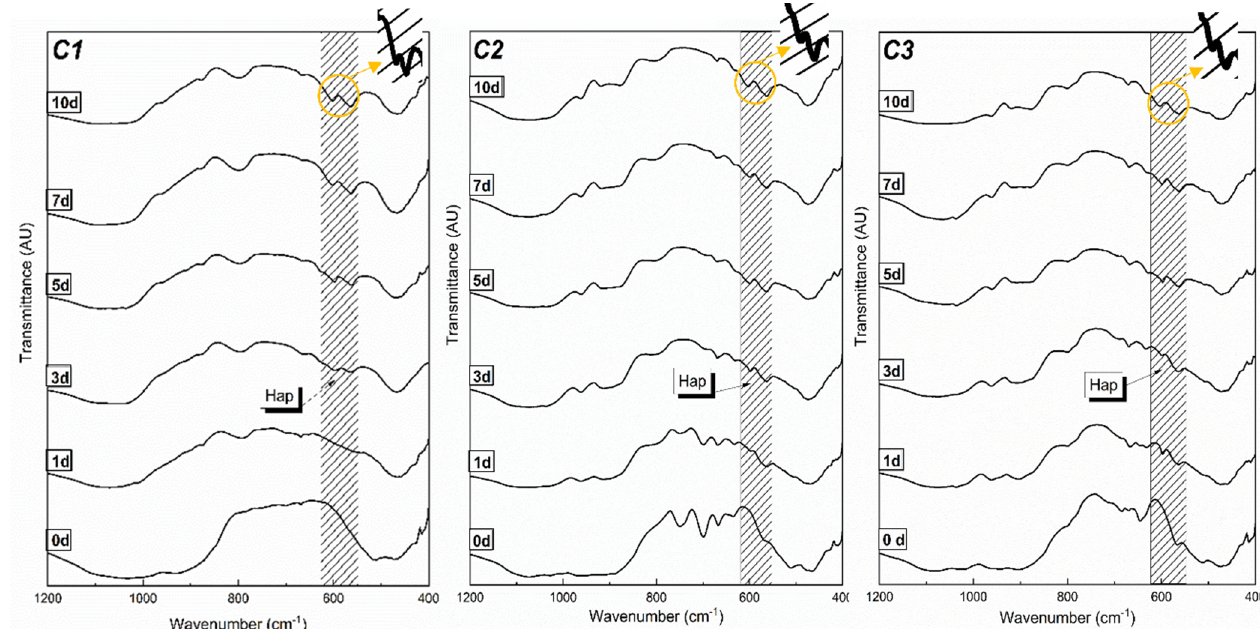
Figure 4. FTIR spectra of all heated samples before and after 1, 3, 5, 7, and 10 days in SBF. The yellow circle with arrow in the spectra of samples after 10 days immersion in SBF indicates the higher magnification of the area with the double peak at 604 and 566 cm − 1 of the apatite formation.